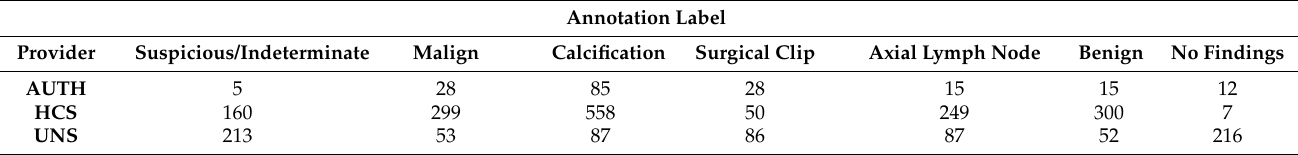
Table 5. Number of MG images per annotation label.